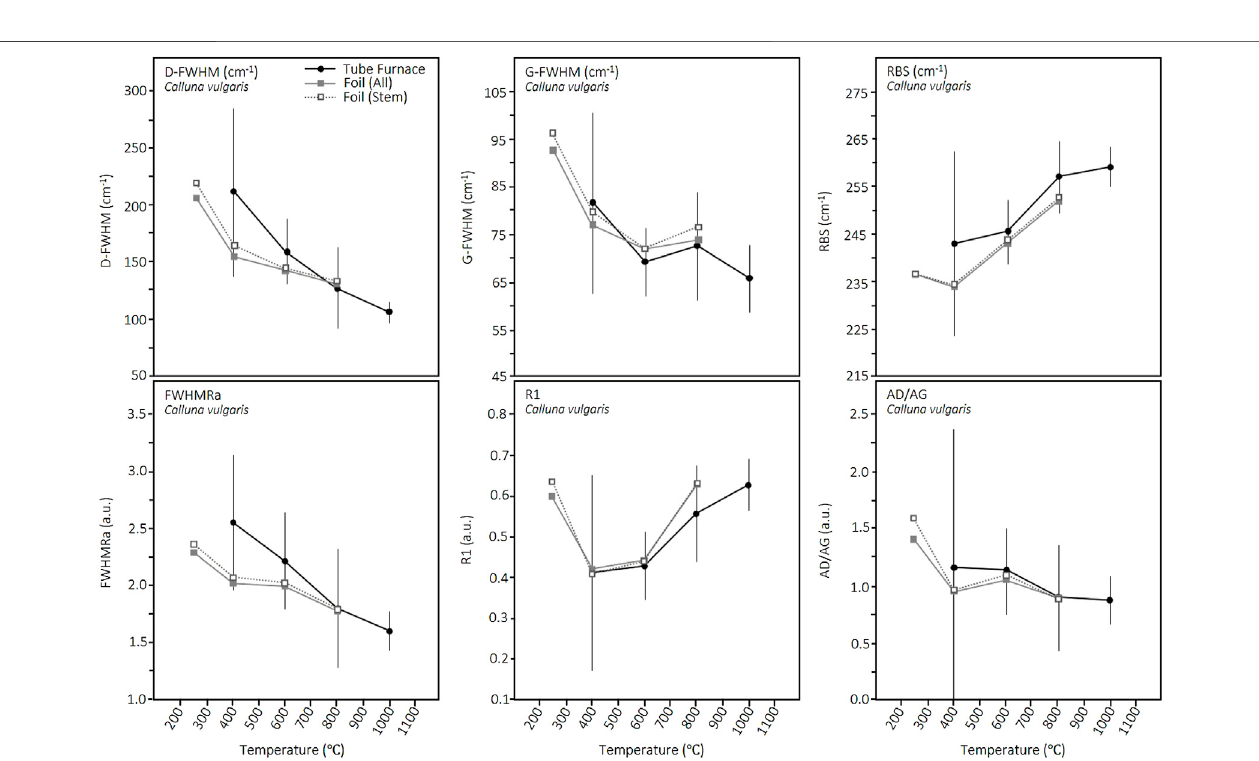
FIGURE5 | Crossplots indicatingthe relationship between median Raman parameter values and the formation temperature ofcharcoals derived from foil (Theurer et al., 2021) and tube furnace pyrolysis ( this study ), respectively. Each data point represents median values from 150 individual spectral deconvolutions, with standard deviationfortubefurnacecharcoalsshownbyverticalblacklines.Keyinthetopleftcrossplotcorrespondstoallsucceedingplots.Here, “ foil(stem) ” and “ foil(all) ”